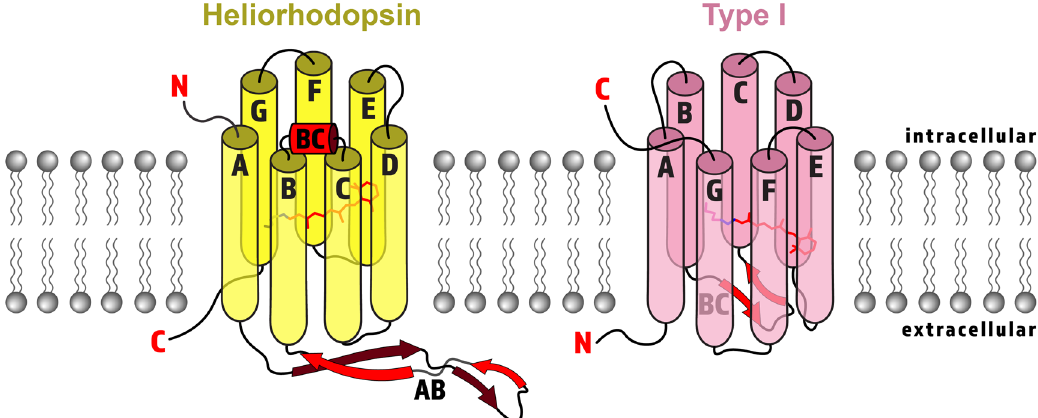
Figure 2. Cartoon structure representation of HeRs (yellow) and type I rhodopsins (pink) with major structural differences emphasized in red. Both HeRs and type I rhodopsins have seven transmembrane α-helices labelled A–G (except enzymerhodopsin, which has eight helices), with a covalently linked retinal chromophore (red sticks) bound to a lysine (pink or yellow sticks) by a Schiff base linkage (blue sticks) on helix G. HeRs have an inverted orientation in the membrane with the N-terminus (red N) facing inward and C-terminus (red C) facing outward, which consequently flips the retinal orientation. HeRs possess a long extracellular A–B loop (AB) composed of a twisted β-sheet (red arrows), and an intracellular B–C loop forming an α-helix (red cylinder labelled BC). In contrast, type I rhodopsins typically have an extracellular B–C loop forming a retinal adaptation like HeR 48C12 (dark-adaption: 97% all- trans- retinal; light-adaption: 40% all- trans- retinal) 1 , or no retinal adaptation like BcHeR (88% all- trans -retinal in both light and dark adapted states) 3 . Despite these similarities, HeRs have unique sequences and topologies. First of all, HeRs share less than 15% sequence identity with other type I and type II rhodopsins 1,5,7,8 . More notably, HeRs have an inverted membrane topology compared to known microbial and animal rhodopsins 1,16 (Fig. 2). HeRs expose their N-terminal tail towards the cytoplasm, while the N-terminus of type I and type II rhodopsins orient towards the outside of the cell.